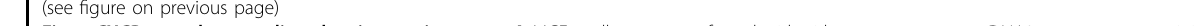
Fig. 1 CXCR4 regulates paclitaxel resistance in cancer. A MCF7 cells were transfected with either empty vector pcDNA3.1 or vector containing the gene for the overexpression of either chemokine receptor CXCR4 or CXCR7 and made stable. These stable cell lines were stained with either APC- conjugated anti-human CXCR4 (CD184) or anti-human CXCR7 antibodies along with their respective isotype control antibodies and analyzed by fl ow cytometry. The surface expression levels of CXCR4 and CXCR7 are represented in histogram overlays (left panel). Western blot analysis of CXCR4 and CXCR7 in the lysate of control and CXCR4/CXCR7 overexpression MCF-7 cells; GAPDH and β -Actin were used as the protein loading control (right panel). B CXCR4 or CXCR7 overexpressing and control MCF7 cells were treated with Doxorubicin (250 nmol/L), Paclitaxel (25 nmol/L), Cisplatin (2.5 μ mol/L), or 5-Fluorouracil (25 μ mol/L) for 72 h and cytotoxicity was measured by SRB assay as described in materials and methods. Percent